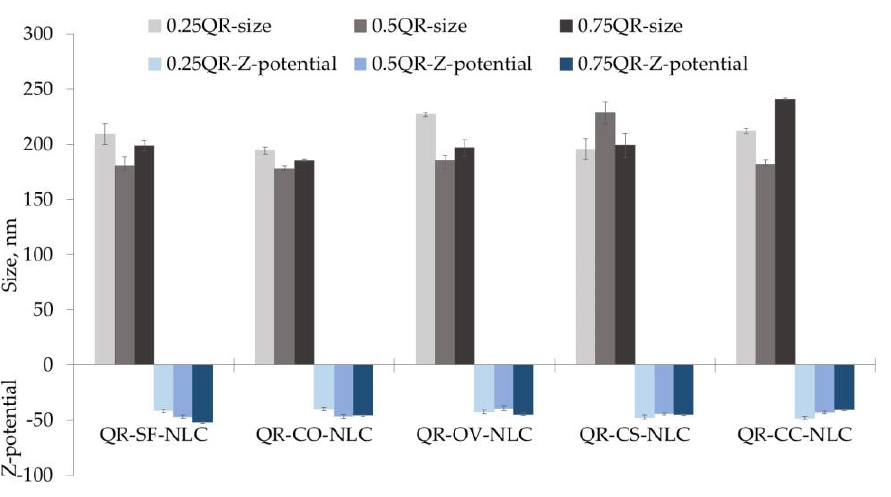
Figure 2. Influence of QR concentration on physicochemical characteristics of QR-NPO-NLCs. QR-NPO-NLCs with 0.5% ( w / v ) QR present an average particle size < 200 nm. Nano- particles between 20 and 200 nm could collect on skin imperfections (pores and follicles), so the drugs from NLCs might more closely interact with the skin, providing better drug penetration through the stratum corneum or the skin [29]. The PDI values stayed below 0.5 for all systems prepared with a QR below 0.5% ( w / v ) and Z-potential above − 40 mV. An exception was found for the 0.5% ( w / v ) QR-CS-NLC, where the average particle size was higher than the other two observed QR concentrations. This may be because of the castor oil ’ s high viscosity due to the presence of ricinoleic acid (Table 1), which inter- feres with experimental reproducibility. Gonzalez-Mira et al. [46] obtained a flurbiprofen (FB)-loaded NLC formulation composed of 0.05 (wt%) FB, 1.6 (wt%) Tween 80, and 50:50 ratios of stearic acid to castor oil, with an average diameter of 288 nm, PI of 0.245, and ZP of − 29 mV. In addition to the different QR solubility in observed NPOs excipients (Table S2; Sup- plementary material), encapsulation efficiency (EE) and drug loading for the systems with 0.5% QR did not show any difference. High EE was observed from 99.90% ± 0.01 (QR-CC- NLC) to 99.99% ± 0.03 (QR-CO-NLC). Drug loading capacity (DL) was 16.67 ± 0.1. All the lipid nanoparticle formulations prepared with each oil demonstrated a high ability to incorporate QR in each of the five tested oils, showing high EE values above 99%. The obtained results for DL demonstrate that the lipid matrices of QR-NPO-NLCs prepared with each natural oil can effectively load quercetin. 2.1.2. Solid-State Characterization of QR-NPO-NLC Systems Using DSC DSC analysis was performed to evaluate the interactions between the lipids and the loaded active compound, analyzing the crystallinity state of empty NPO-NLCs and QR- NPO-NLCs (Figure 3, Table 2). Figure 3 shows the DSC thermograms of the MA, QR, and QR-NPO-NLCs. The curves of the QR-NPO-NLCs show two distinct endothermic peaks. The first, between 41.4 °C (QR-OV-NLC) and 50.3 °C (QR-SF-NLC), corresponds to the Tm of MA. QR demonstrated a sharp endothermic peak at 326.5 °C, which shifted distinctly to 315.4, 322.2, 321.7, 302.0, and 312.5 °C in the presence of SF, OV, CO, CC, and CS, respectively. The nature of liquid lipids considerably impacted the depression of Tm of QR. The melt- ing point depression compared with the pure solid lipid, MA (56.3 °C), and QR (326 °C) was observed for all systems (Figure 3).